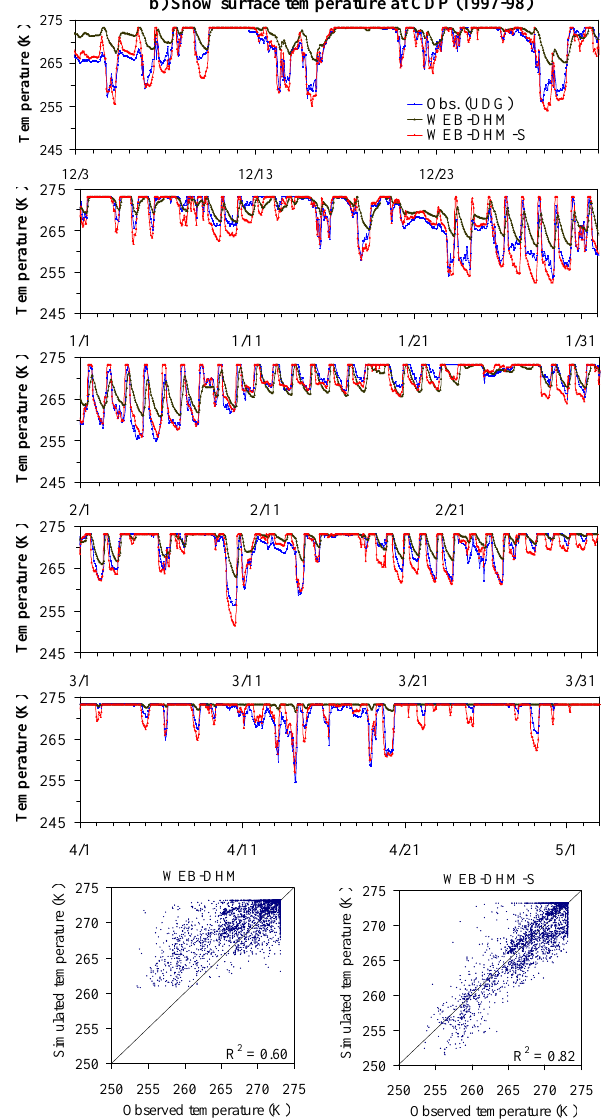
Fig. 4a. Comparison of observed and simulated hourly snow sur- face temperature along with its scatterplots at CDP (1996–1997) from 11 November 1996 to 3 April 1997.